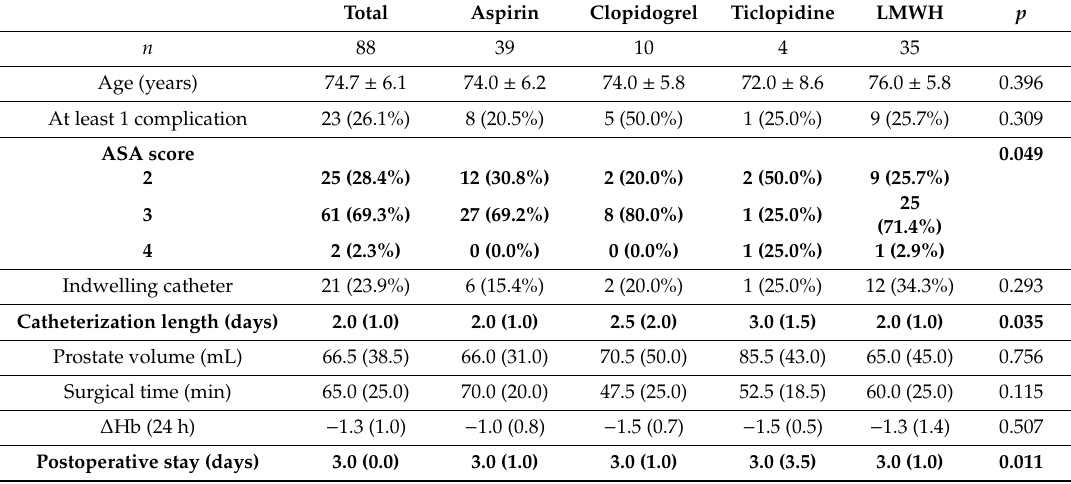
Table 1. Patient characteristics according to antithrombotic treatments.